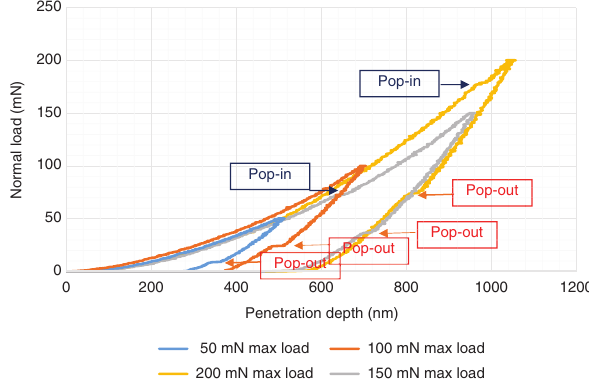
Figure 3: Normal load versus penetration depth curves of silicon wafers for four different loads, from 50 mN to 200 mN.